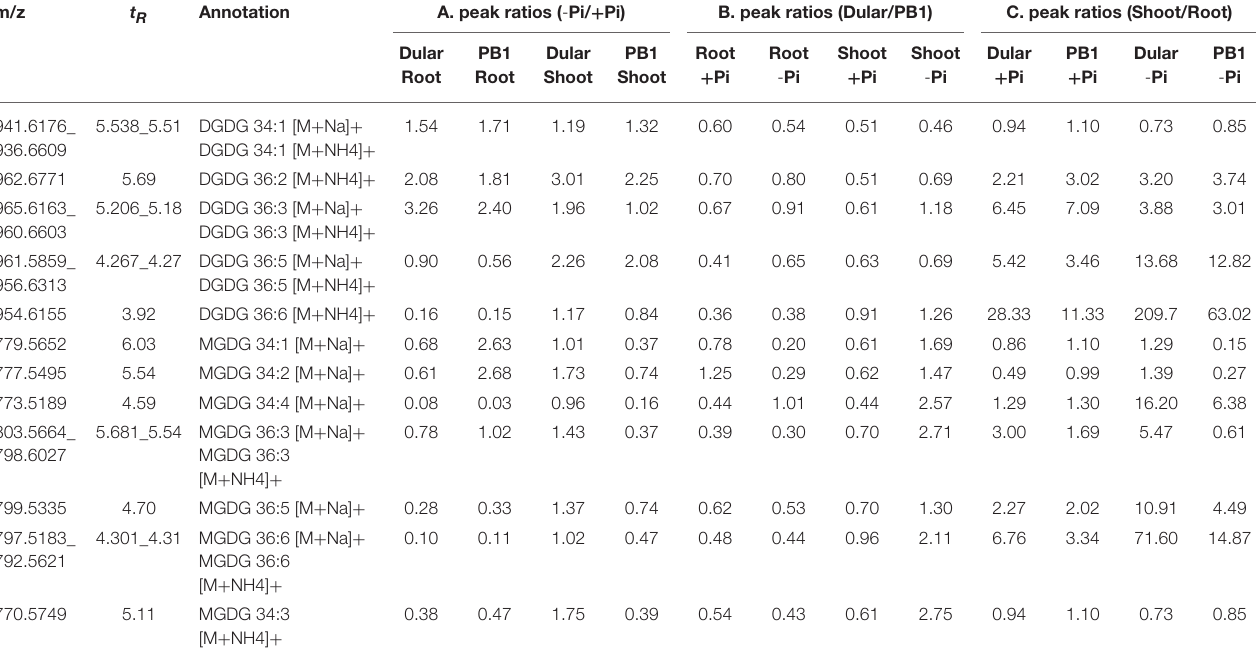
TABLE 4 | LC-QTOF analysis of relative concentrations of galactolipids under Pi